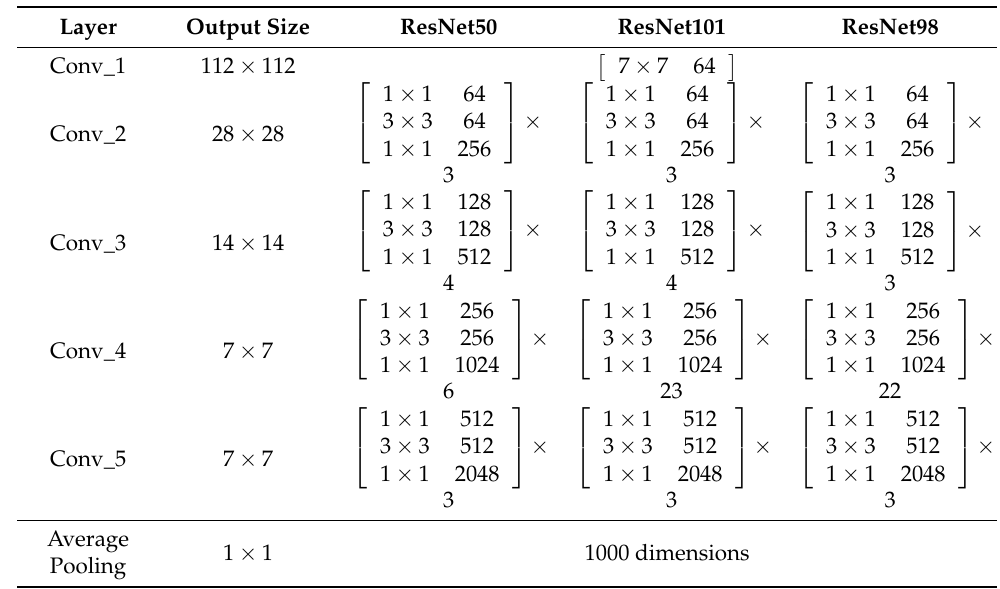
Table 1. The structures of the ResNets: ResNet50, ResNet98, and ResNet101 represent that the number of layers is 50, 98, and 101,